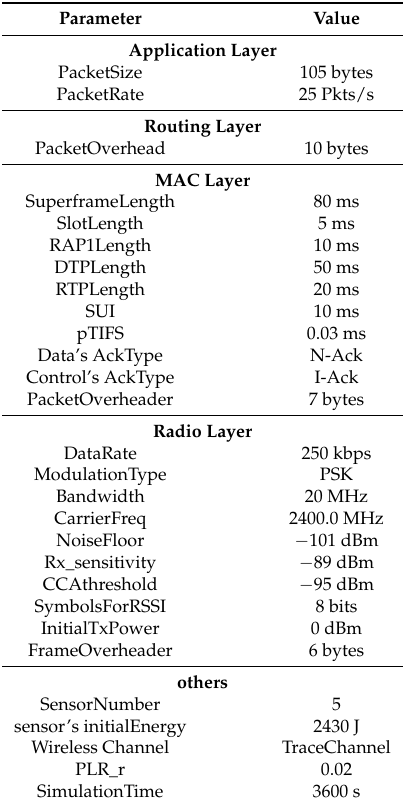
Table 3. Simulation parameters for